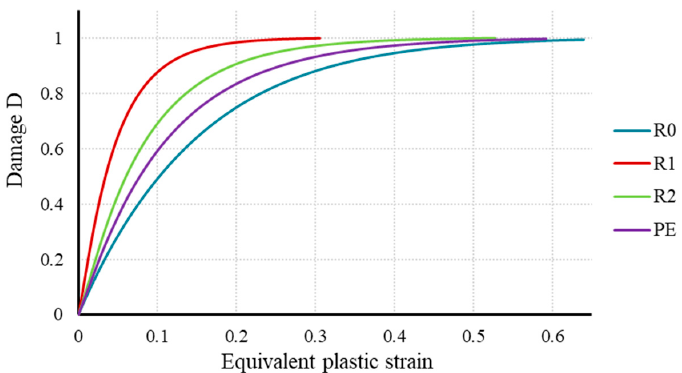
Figure 9. Nonlinear damage evolution for monotonic loading for four specimens at different stress states when introducing the parameter C g in Equation (7).